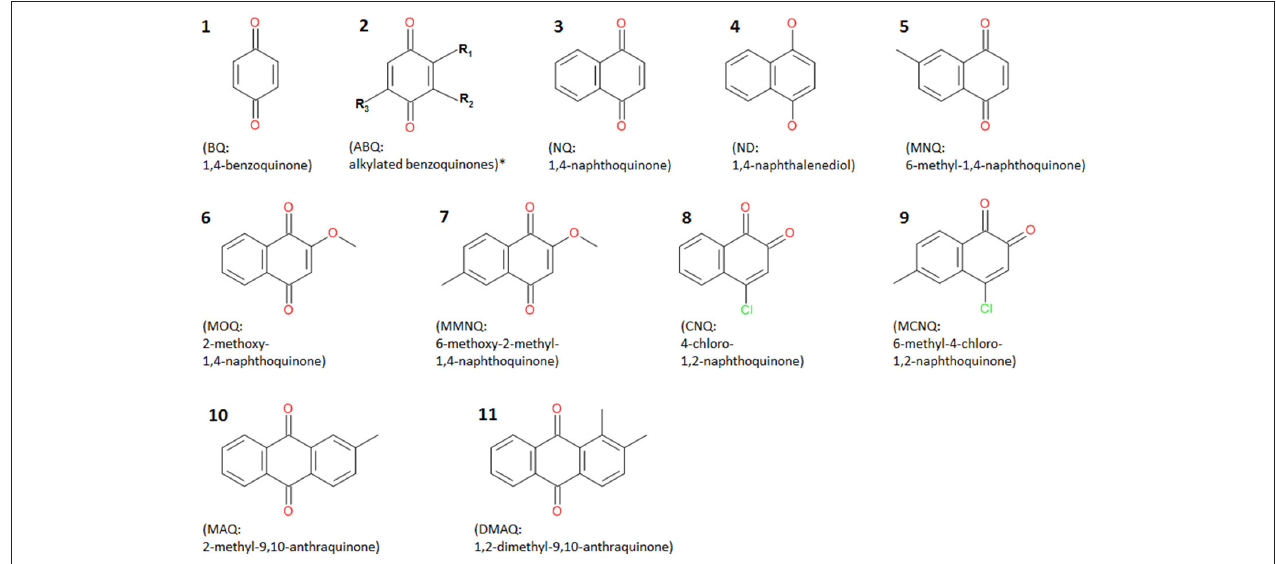
FIGURE 1 | Chemical formulas of quinonic compounds found in the secretions of palpatorean harvestmen. Numbers refer to chemical characters in Figure 3 . *Alkylated benzoquinones may contain different substituents: R 1 = H or CH 3 or C 2 H 5 or C 3 H 7 ; R 2 = H or CH 3 ; R 3 = H or CH 3 or C 2 H 5 (according to Hara et al., 2005 and Gnaspini and Hara,